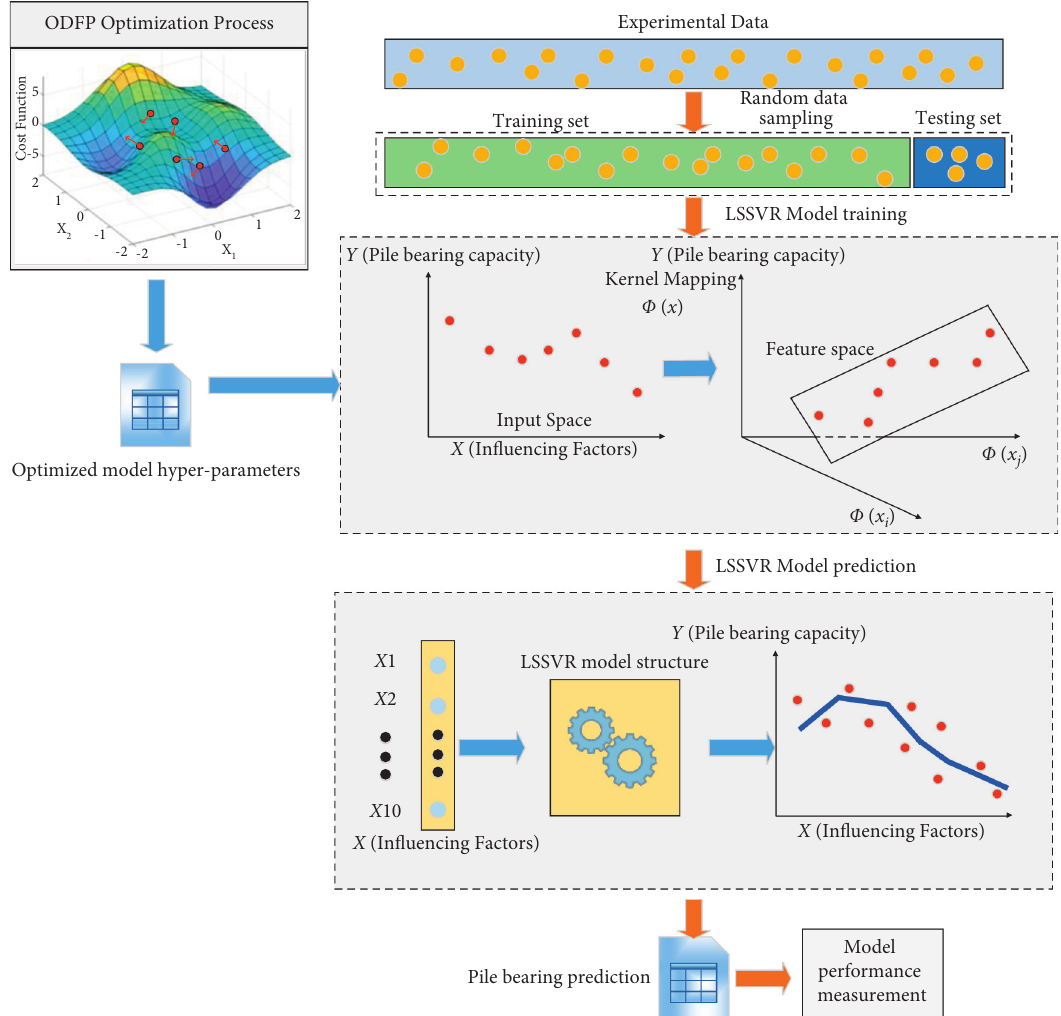
Figure 6: Overall structure of the proposed ODFP-LSSVR-based pile capacity prediction